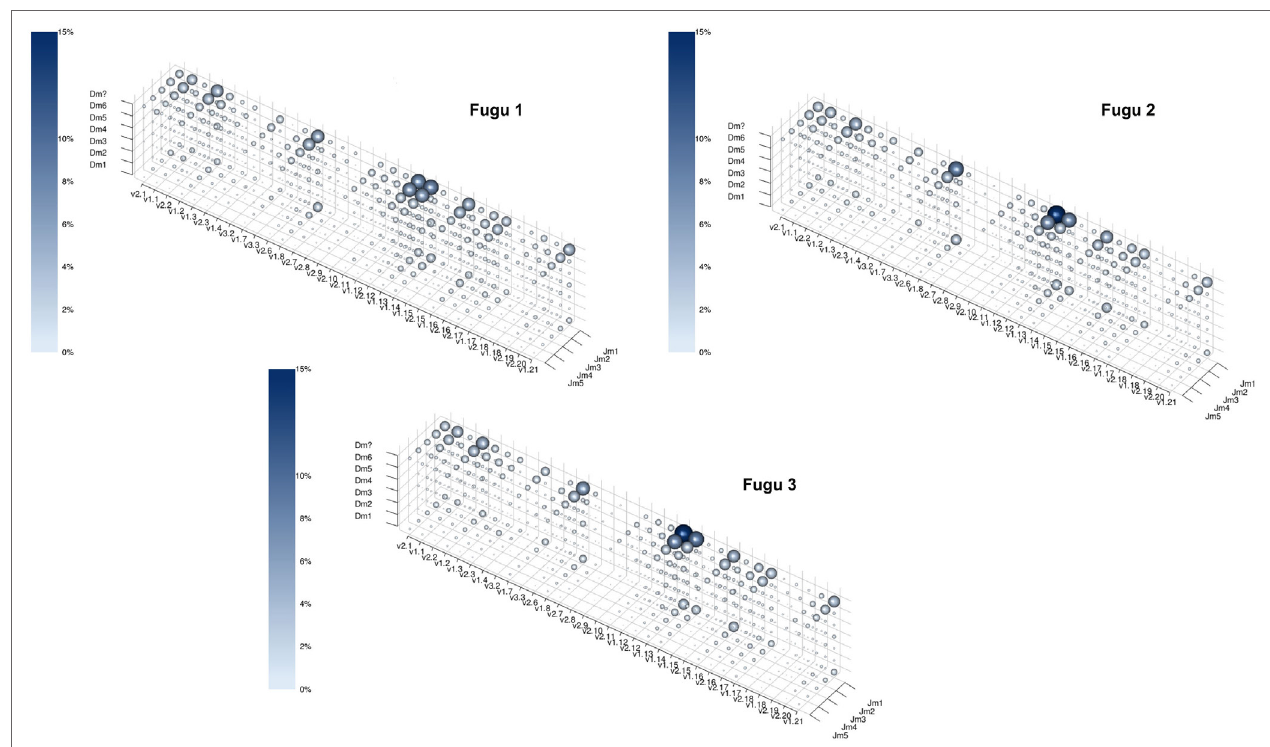
FigUre 2 | The captured VDJ repertoires for individual torafugu. Each point in the three-dimensional space represents a unique VDJ combination. Both the size of the sphere and the intensity of the color correspond to the percentage of the number of reads that match the VDJ combination relative to all captured reads. To prevent a sphere overlapping with others, the size of the sphere was transformed by n (1/4) , where n is the percentage of the corresponding VDJ combination. “Dm?” represents ambiguous D